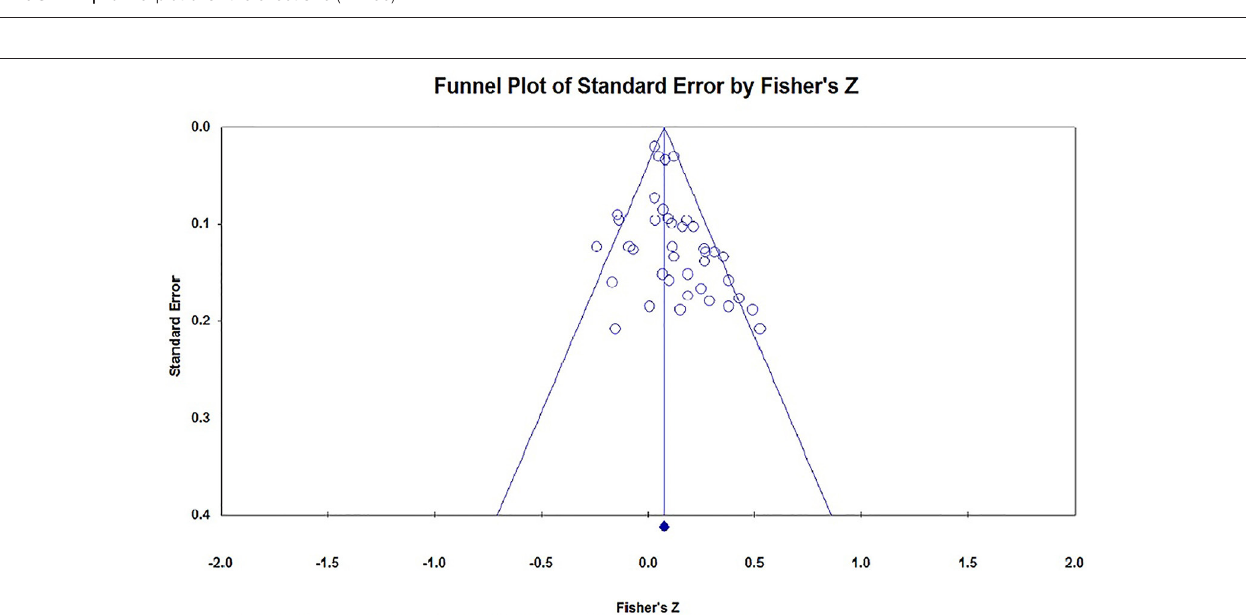
FIGURE 3 | Funnel plot of the effect size of masculine preference ( x =